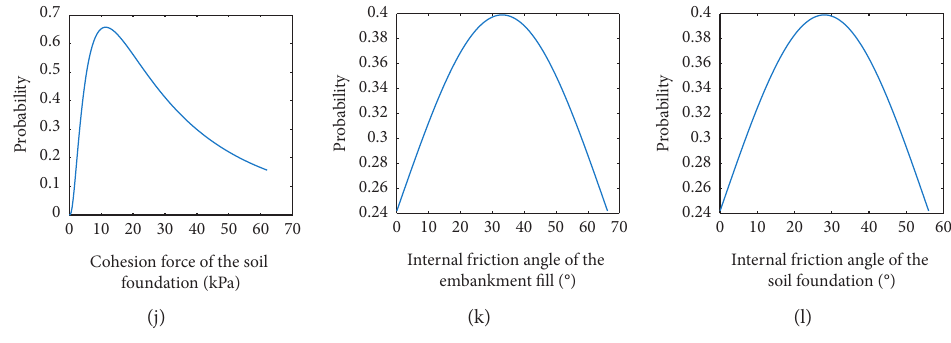
Figure 5: Probability distribution curves of the structural parameters.